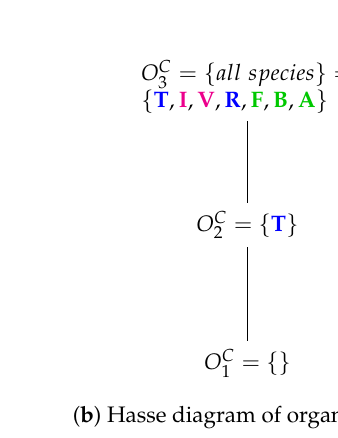
Figure 10. The Cao Model [27] with seven variables: target cells ( T ), infected cells ( I ), viruses ( V ), resistant cells ( R ), interferon ( F ), B cells ( B ), and antibodies ( A ).